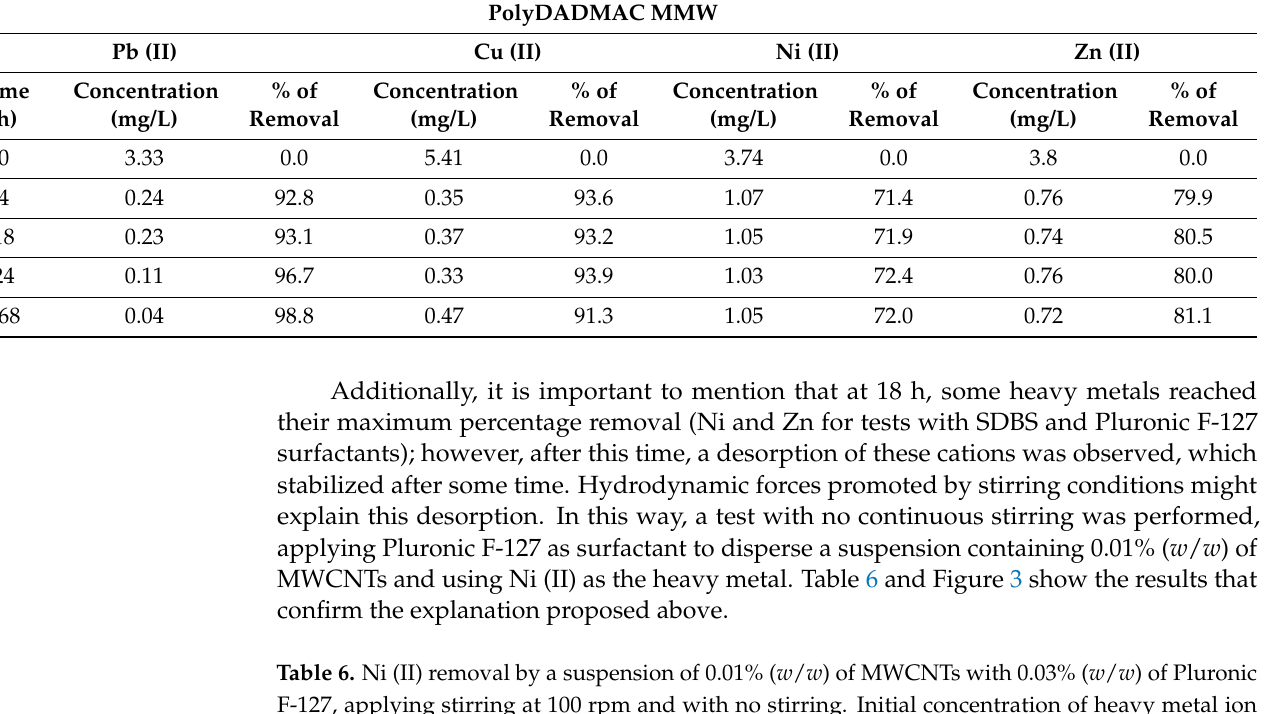
Table 6. Ni (II) removal by a suspension of 0.01% ( w / w ) of MWCNTs with 0.03% ( w / w ) of